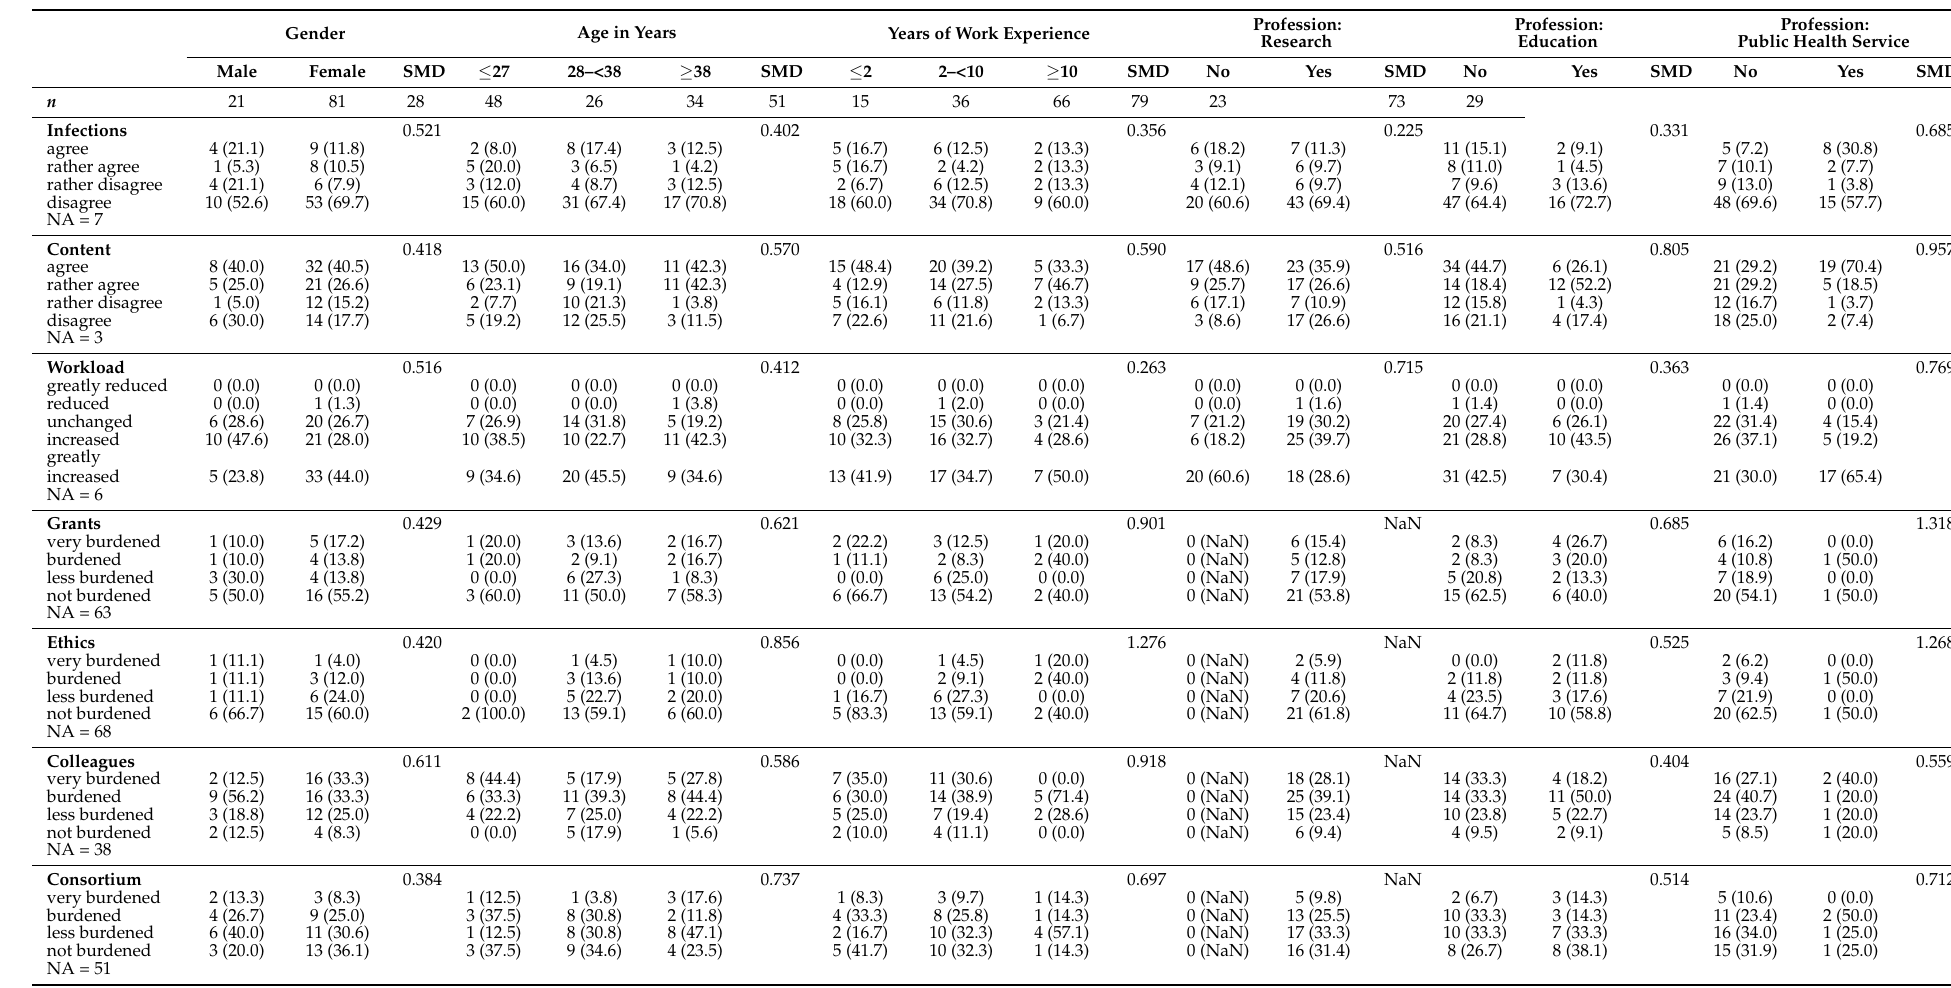
Table 5. Experiences of employed participants, stratified for gender, age, years of work experience, and profession ( n =